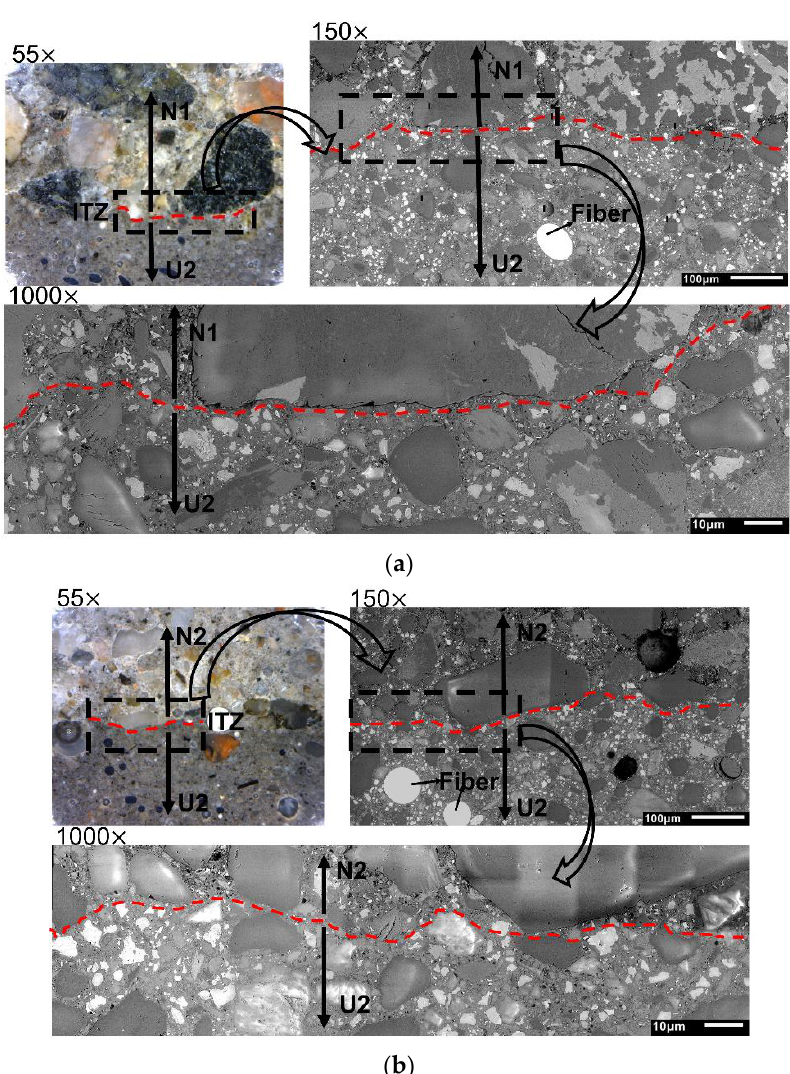
Figure 5 . Transition zone observed in hybrid concretes at 55× magnification (digital microscope) Figure 5. Transition zone observed in hybrid concretes at 55 × magnification (digital microscope) and and at 150× and 1000× magnification (SEM): ( a ) U2N1, ( b ) U2N2 . at 150 × and 1000 × magnification (SEM): ( a ) U2N1, ( b )